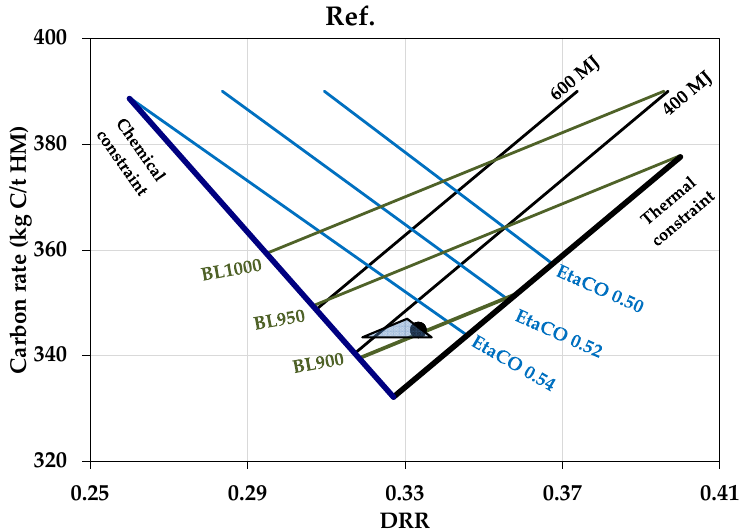
Figure 4. CDRR diagram of the reference case.